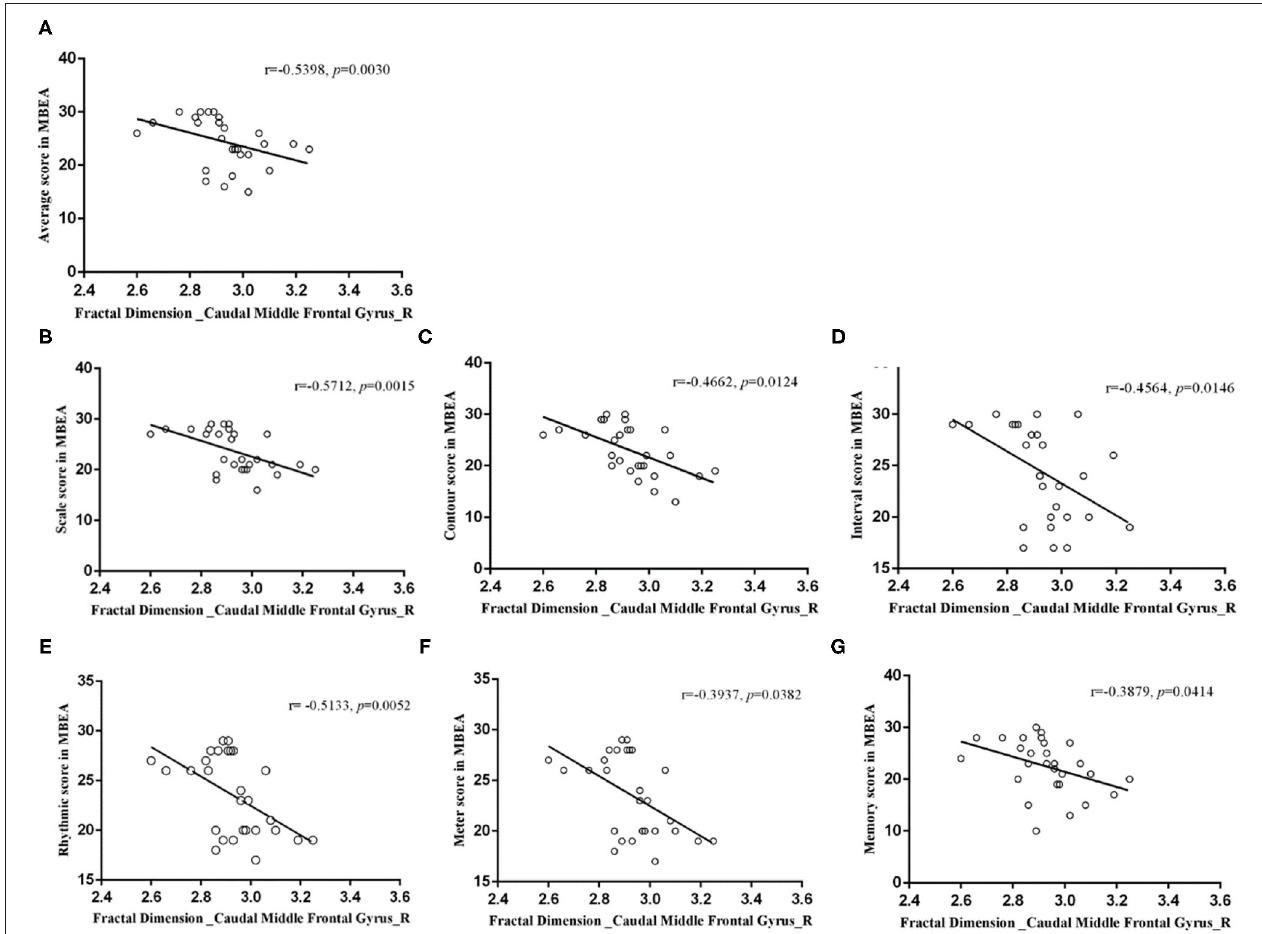
FIGURE 6 | Correlations between the mean fractal dimension value in the right caudal middle frontal gyrus and MBEA test and subtest scores. In the right caudal middle frontal gyrus, the mean fractal dimension value was negatively correlated with the mean MBEA score (A) , pitch score (B) , contour score (C) , interval score (D) , rhythmic score (E) , meter score (F) , and memory score (G)